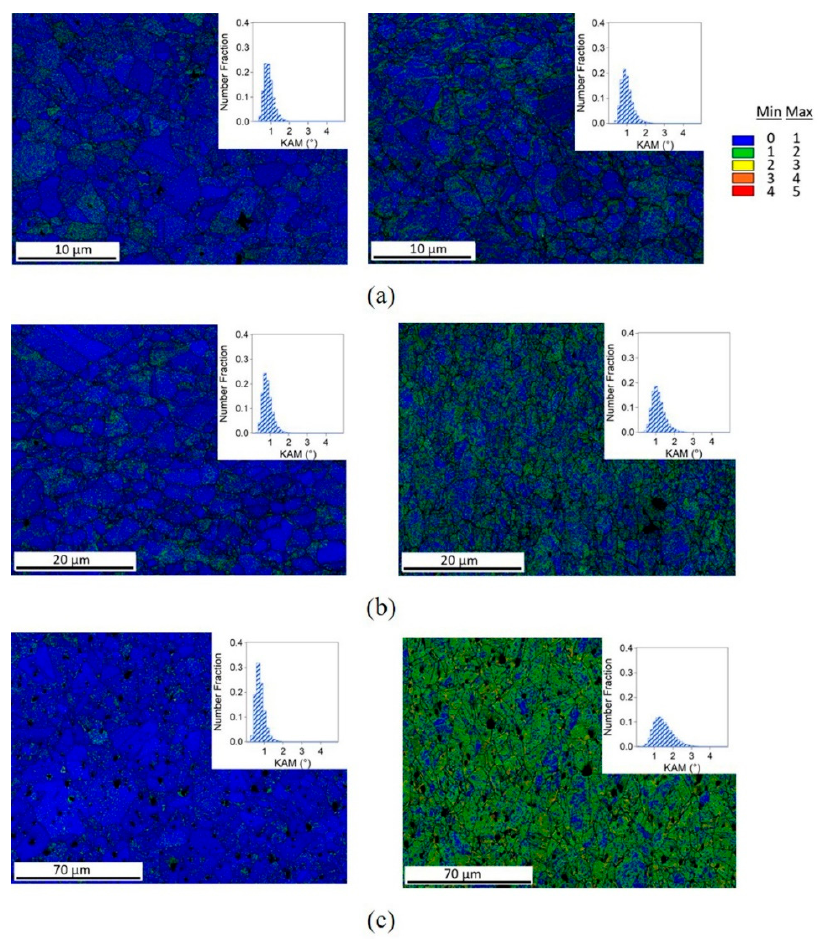
Figure 10. First neighbor kernel average misorientation (KAM)+IQ cartographies of samples 1 (d = 0.82 µ m) ( a ), 3 (d = 1.39 µ m) ( b ) and 4 (d = 4 µ m) ( c ) in the initial state ( left ) and for fractured samples ( right ). Color legend represents the kernel average misorientation in degrees. Inserts display the distribution of first neighbor KAM values for each state and sample.